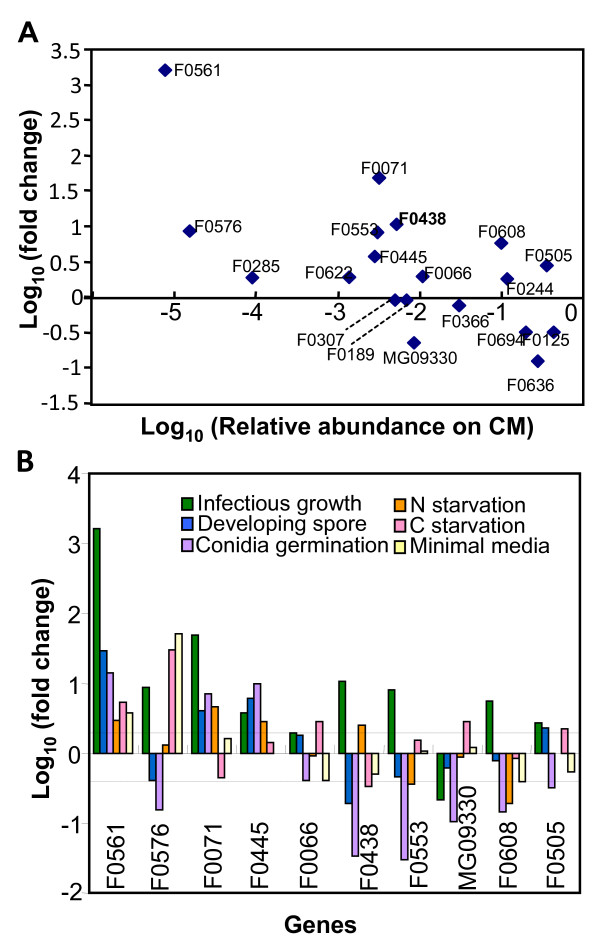
Expression of infection EST specific fungal genes analyzed by real-time RT-PCR. Relative abundance and fold changes were calculated as described in Experimental Procedures. Cyclophillin was used as an internal control. (A) Fold changes during infectious growth were compared relative abundance during growth in complete medium. (B) Fold changes during infectious growth, conidiation, conidial germination, and nutrient starvation conditions were depicted as log scale.